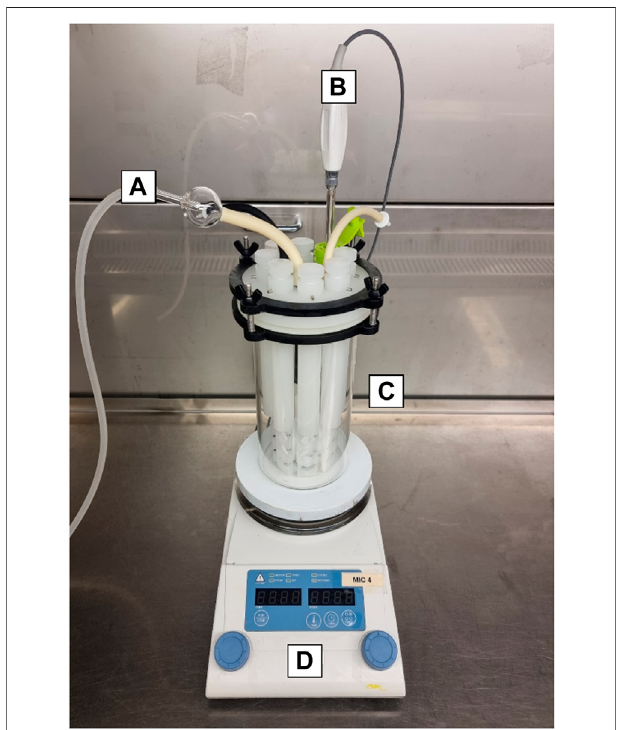
FIGURE 1 | CDC CBR-90 Anaerobic Reactor design consisting of a sealed lid with gas and media inlet and outlet ports (A) , thermocouple probe (B) and glass body (C) , mounted on a hotplate (D) . Inside the reactor are coupon holding rods and a central magnet for media